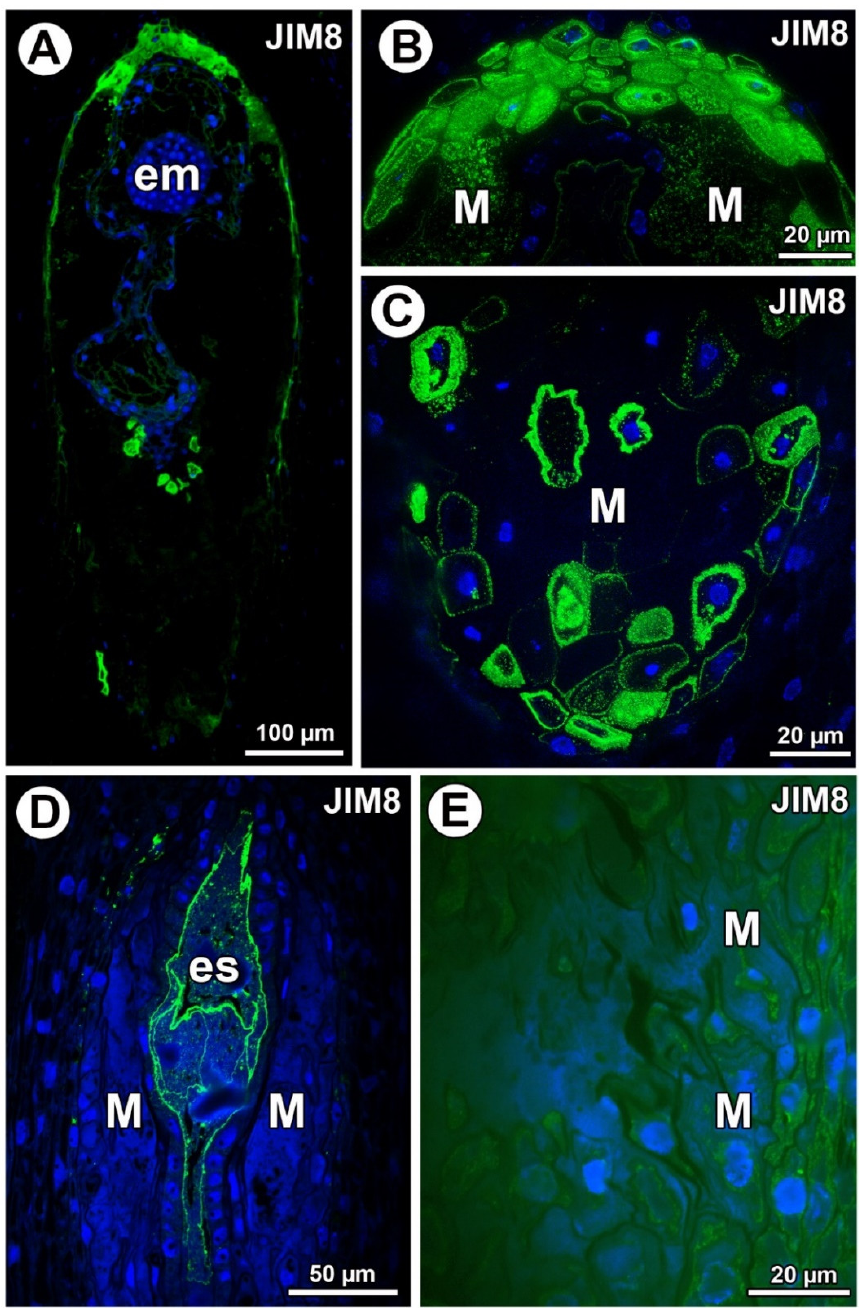
Figure 3. Arabinogalactan proteins (labeled with JIM8) detection. ( A ) Section through the young seed of Taraxacum o ffi cinale ; note the presence of embryo (em). ( B ) Higher magnification of micropylar pole of T. o ffi cinale seed; note that arabinogalactan proteins (AGPs) occurred in the mucilage in lysigenous cavities (M). ( C ) Section through the chalazal part of young seed of T. o ffi cinale with mucilage cells (M). ( D ) Section through the ovule of Pilosella o ffi cinarum ; note the presence of embryo sac (es). ( E ) Detection of AGPs in protoplasts of various ovular cells of P. o ffi cinarum ; mucilage cells